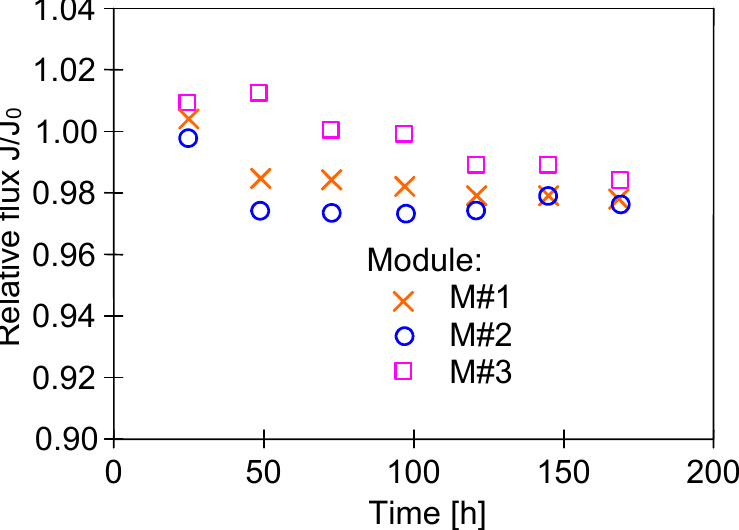
Figure 8. Changes in the relative flux during the initial period of the MD process run. Feed: NaCl solution (35 g/L), T F = 60 °C.